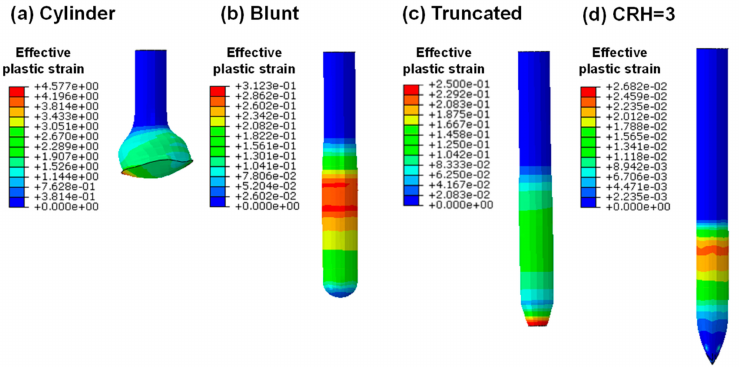
Figure 11. Deformation of the projectile after the normal penetration: ( a ) Cylinder, ( b ) Blunt, ( c ) Truncated, and ( d ) CRH =